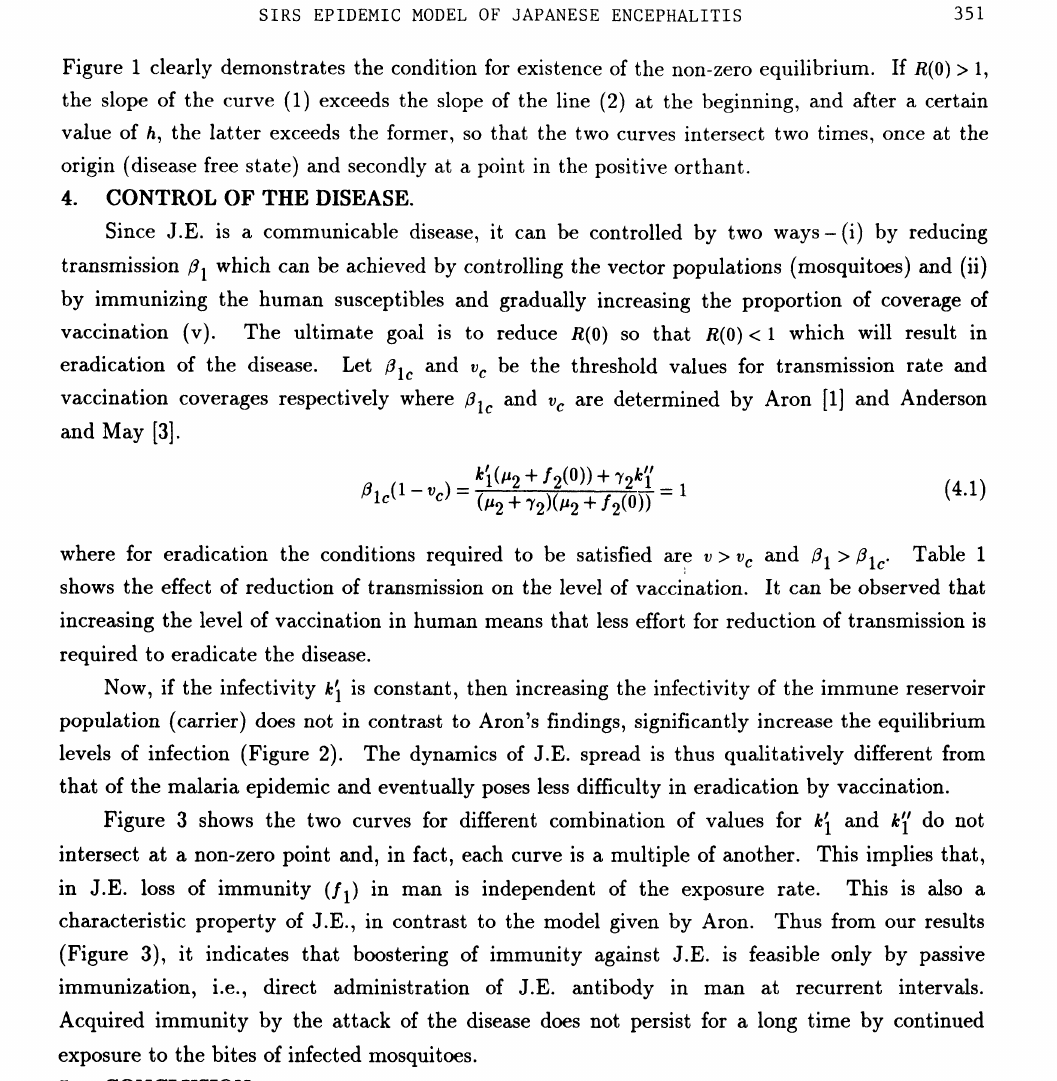
Figure clearly demonstrates the condition for existence of the non-zero equilibrium. If R(0) > 1,